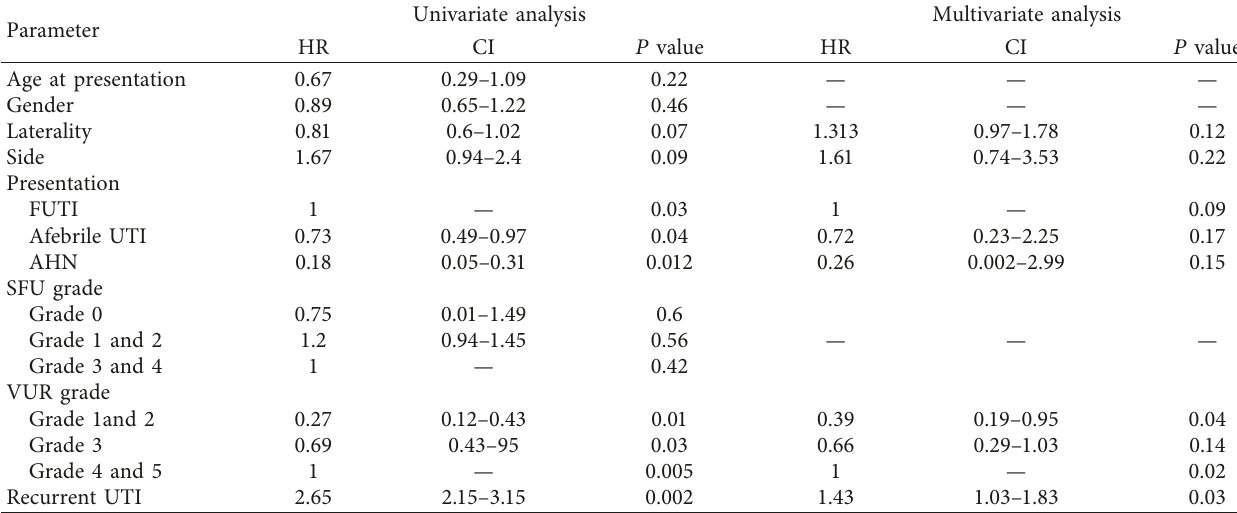
Table 3: Univariate and multivariate analysis to evaluate the possible independent predictors of renal scarring